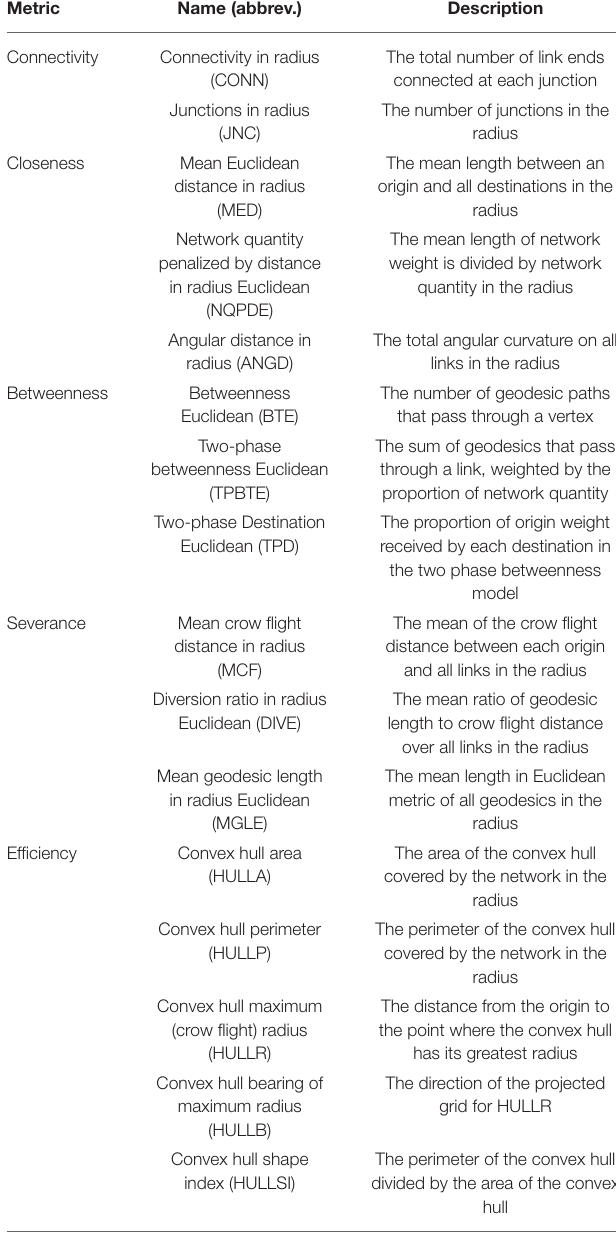
TABLE 1 | The description of street network